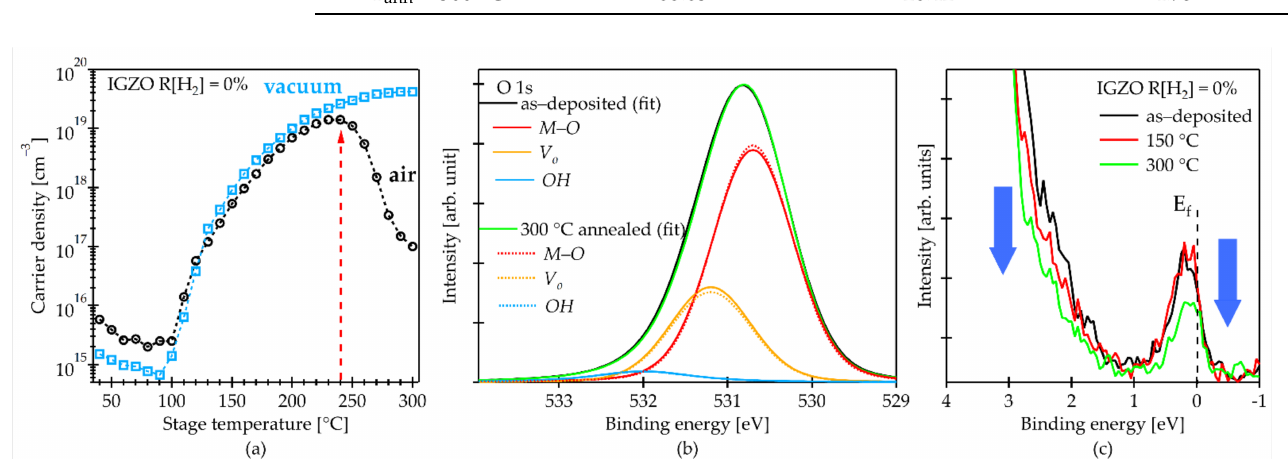
Figure 1. Properties of conventional IGZO film: ( a ) carrier density obtained during the in situ Hall measurement in air and vacuum; ( b ) O 1s spectra before and after 1 h annealing in air at 300 ◦ C; ( c ) electronic structure around the band gap region for as-deposited and after annealing at various